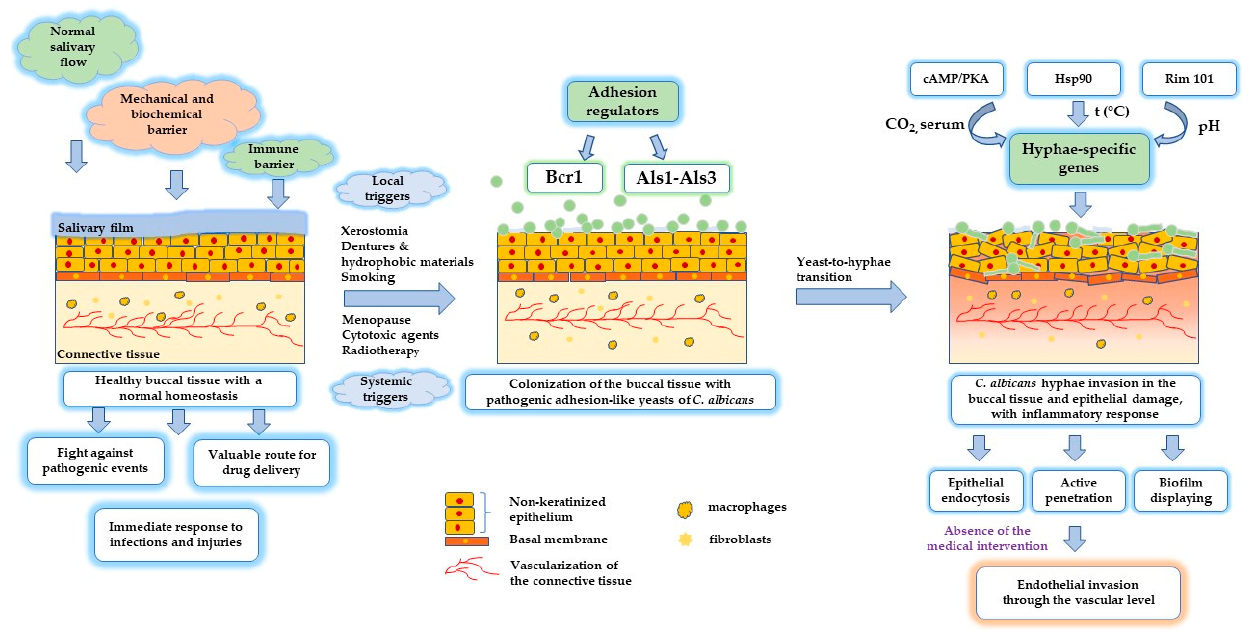
Figure 1. Dynamics in the colonization process of the oral mucosa with C. albicans and molecular processes, triggering yeast to hyphae transition and invasion.